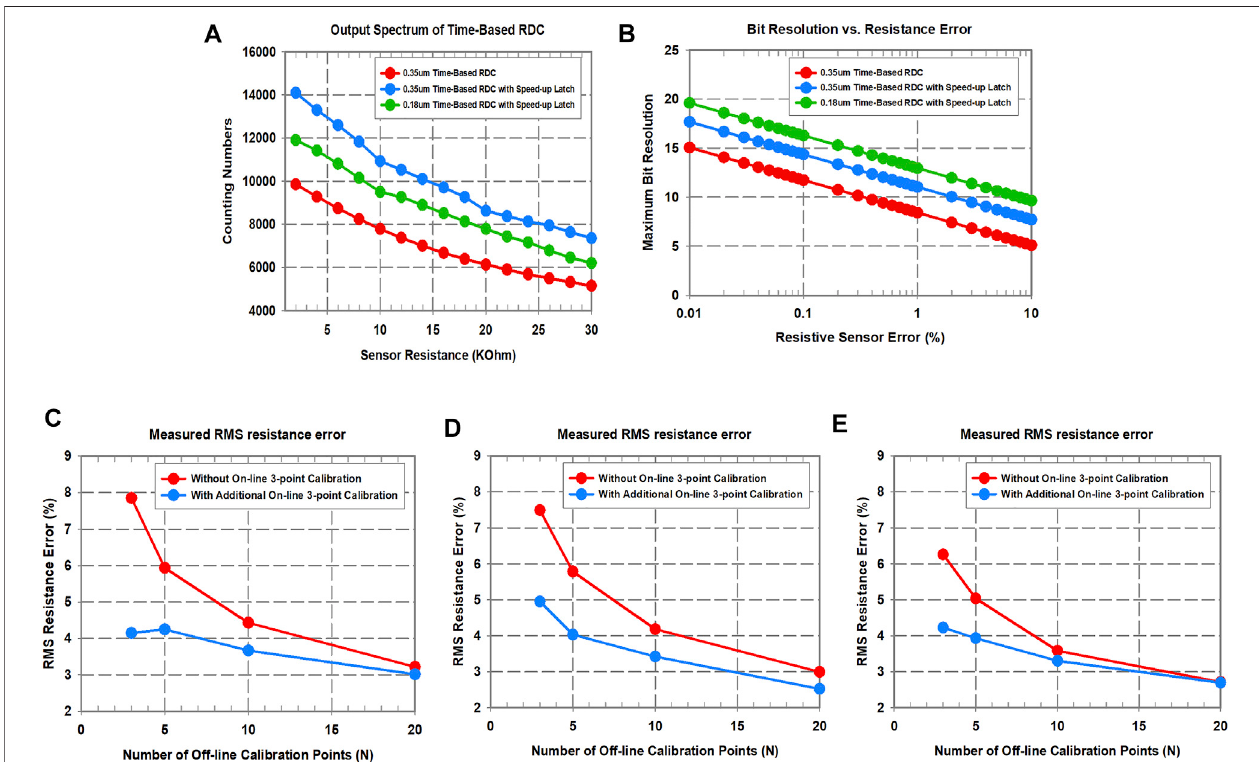
FIGURE 13 | (A) Measured resistance to frequency transfer function of the three RDC designs, (B) maximum achievable bit-resolution with respect to resistive sensorerrorofthethreeRDCdesigns, (C) measuredRMSresistanceerror(%)forper-deviceoff-linecalibration,followedbyonlinethree-pointcalibrationforthe0.35- μ m time-based RDC (design 1), (D) measured RMS resistance error (%) for per-device off-line calibration, followed by online three-point calibration for the 0.35- μ m time- based RDC with the speed-up latch (design 2), and (E) measured RMS resistance error (%) for per-device off-line calibration, followed by online three-point calibration for the 0.18- μ m time-based RDC with the speed-up latch (design 3).